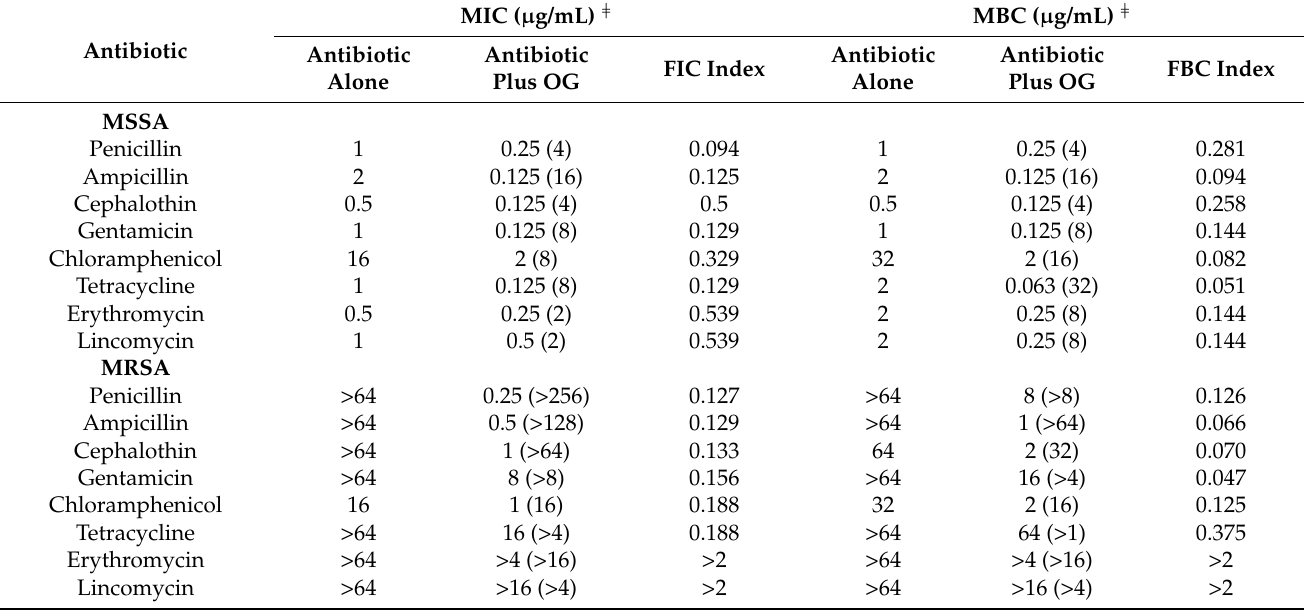
Table 1. Synergistic bacteriostatic and bactericidal activities of octyl gallate (OG) and antibiotic